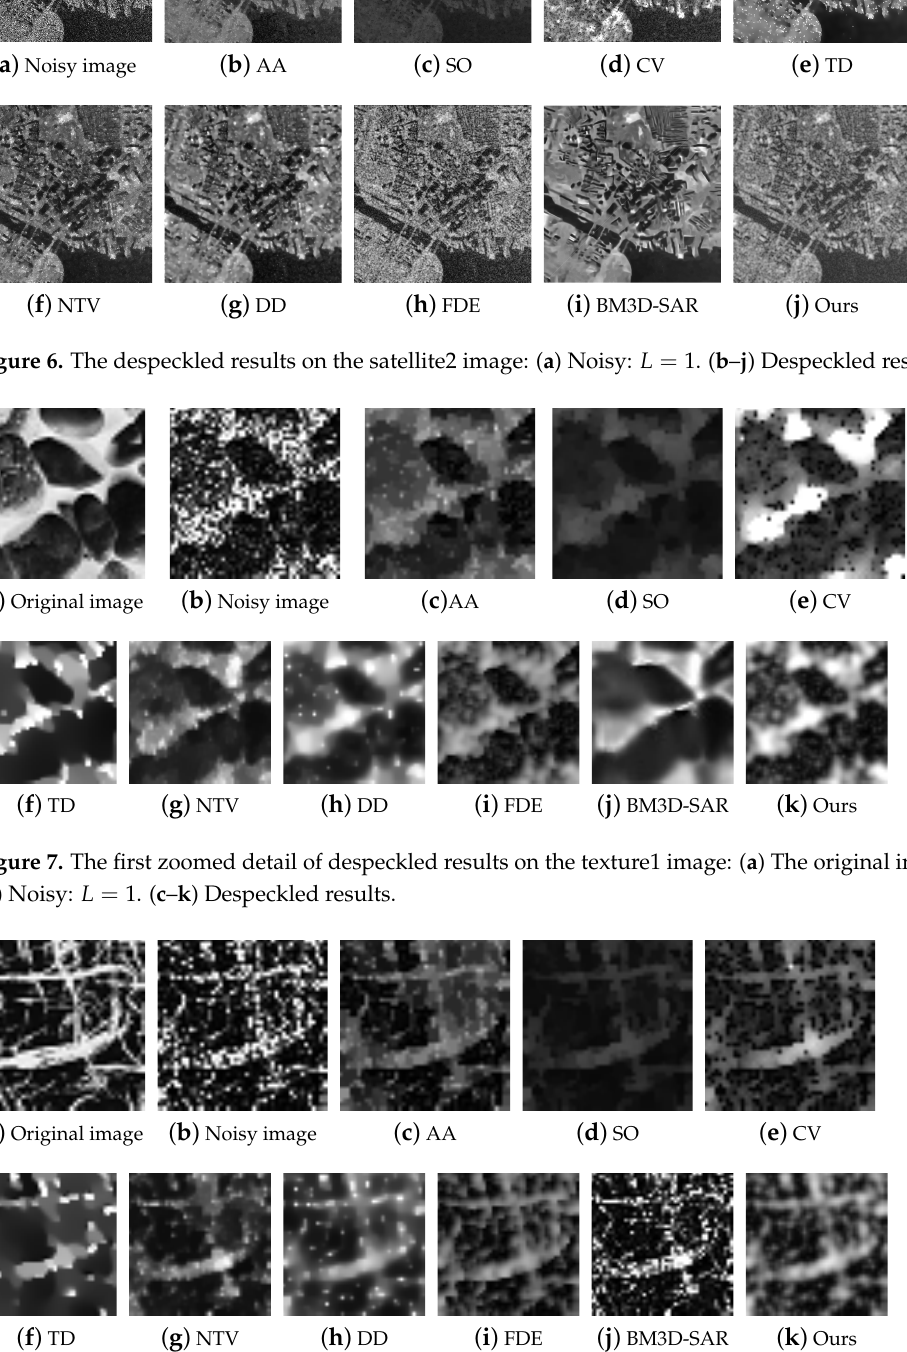
Figure 8. The second zoomed detail of despeckled results on the texture1 image: ( a ) The original image. ( b ) Noisy: L = 1. ( c – k ) Despeckled